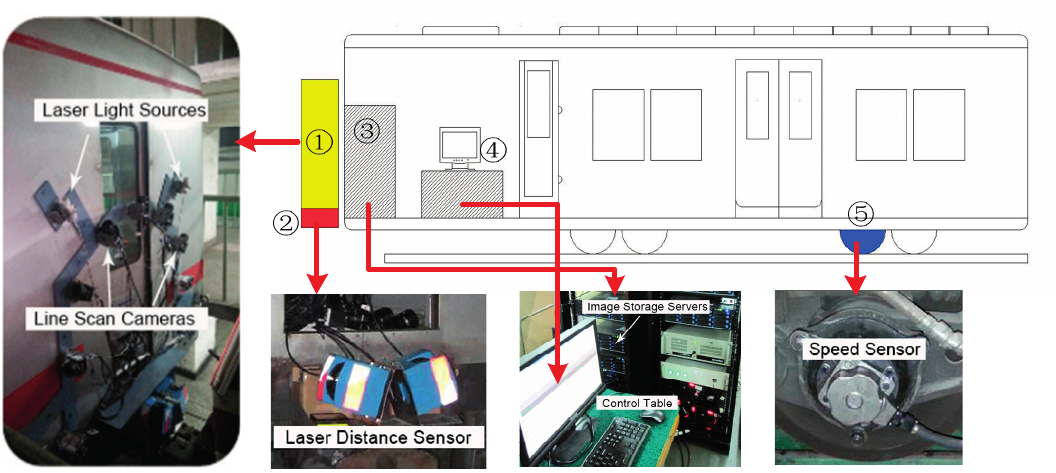
Figure 2. Image acquisition system for subway tunnel monitoring, in which: ① image sensing terminal; ② laser distance sensors; ③ image storage and processing servers; ④ central control system; ⑤ speed